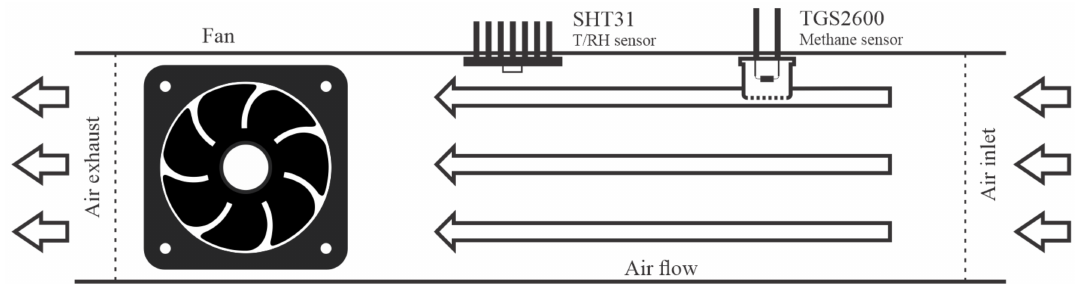
Figure 3. Active air circulation used in the system to improve signal resolution. The temperature and relative humidity sensor were installed next to the methane